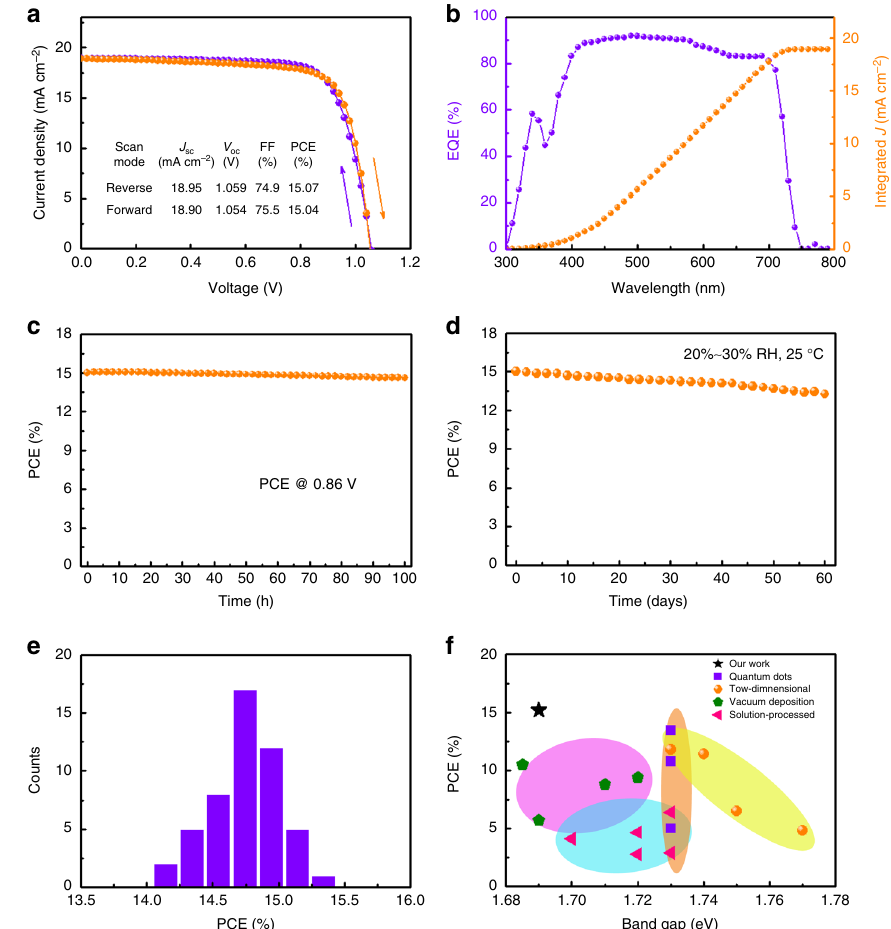
Fig. 4 Performance of the best device with PEAI: a J – V characteristics, b EQE, c steady-state measurement of the PCE, d long-term stability of the best- performing device, e histogram of device ef fi ciency distribution over 50 cells, and f PCE distribution of CsPbI 3 PSCs as a function of band gap relative to published